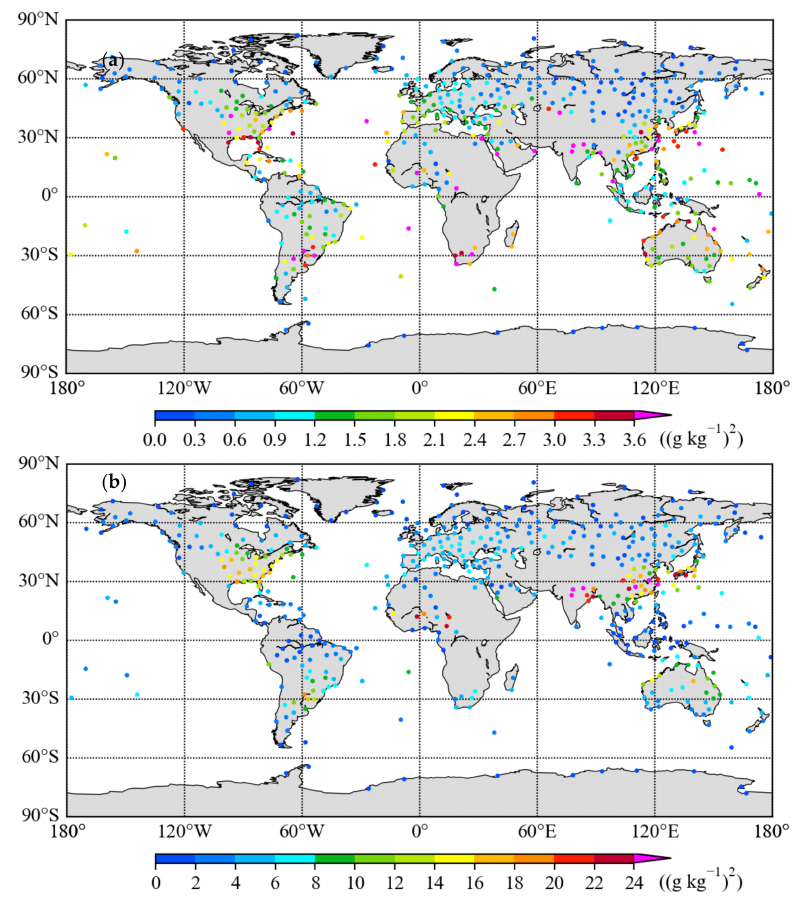
Figure 10. Same as Figure 8 except for RS specific humidity.